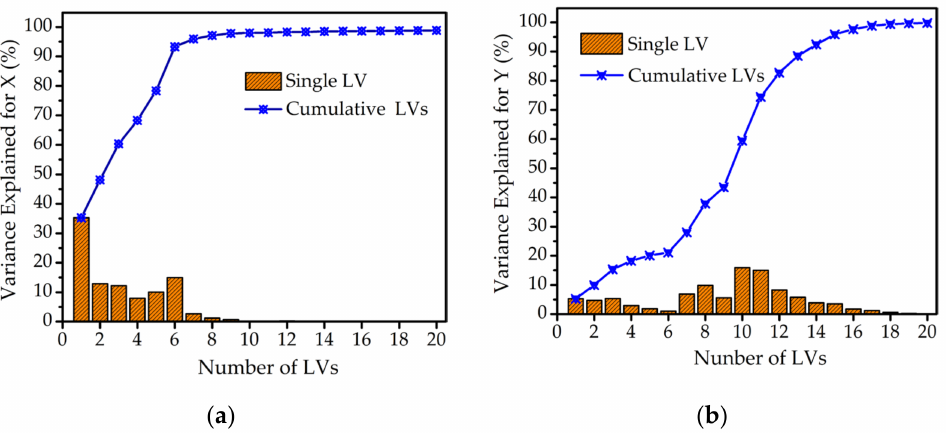
Figure 3. Description of the variance explained by single LV and cumulative LVs. ( a ) Variance explained for matrix X. ( b ) Variance explained for matrix